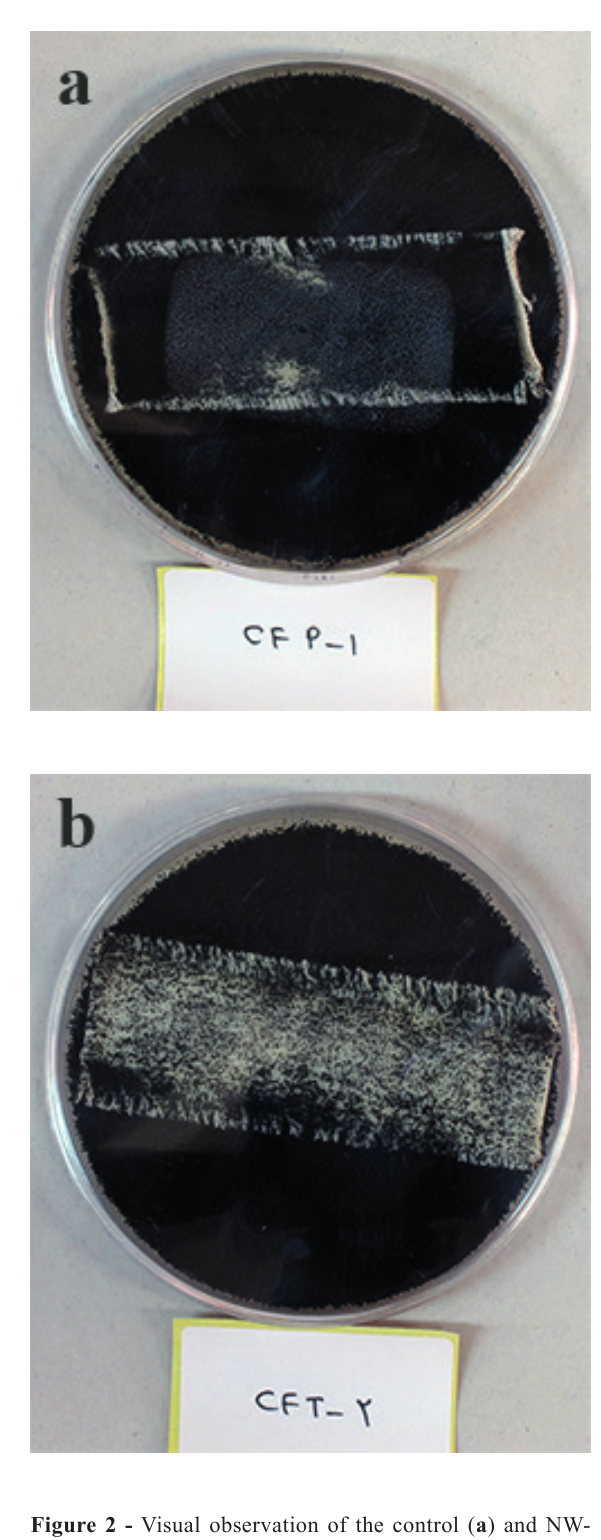
Figure 2 - Visual observation of the control ( a ) and NW- impregnated ( b ) specimens after three months of exposure to A. nigra in Petri